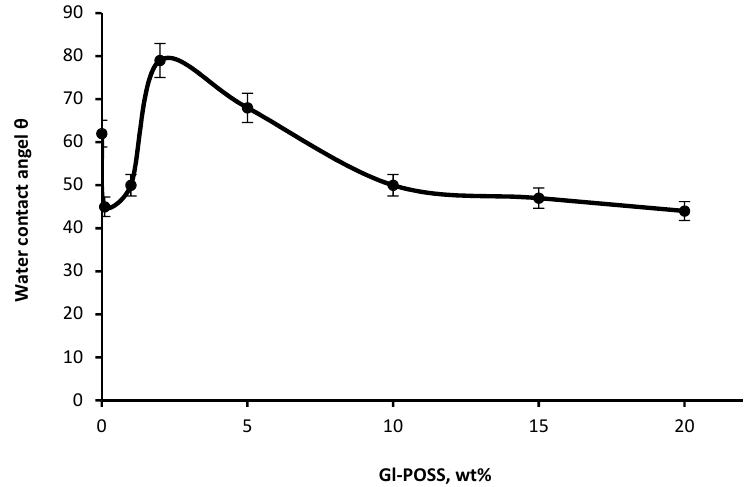
Figure 5. The dependence of the water contact angle on POI-Gl-POSS polymers on the Gl-POSS